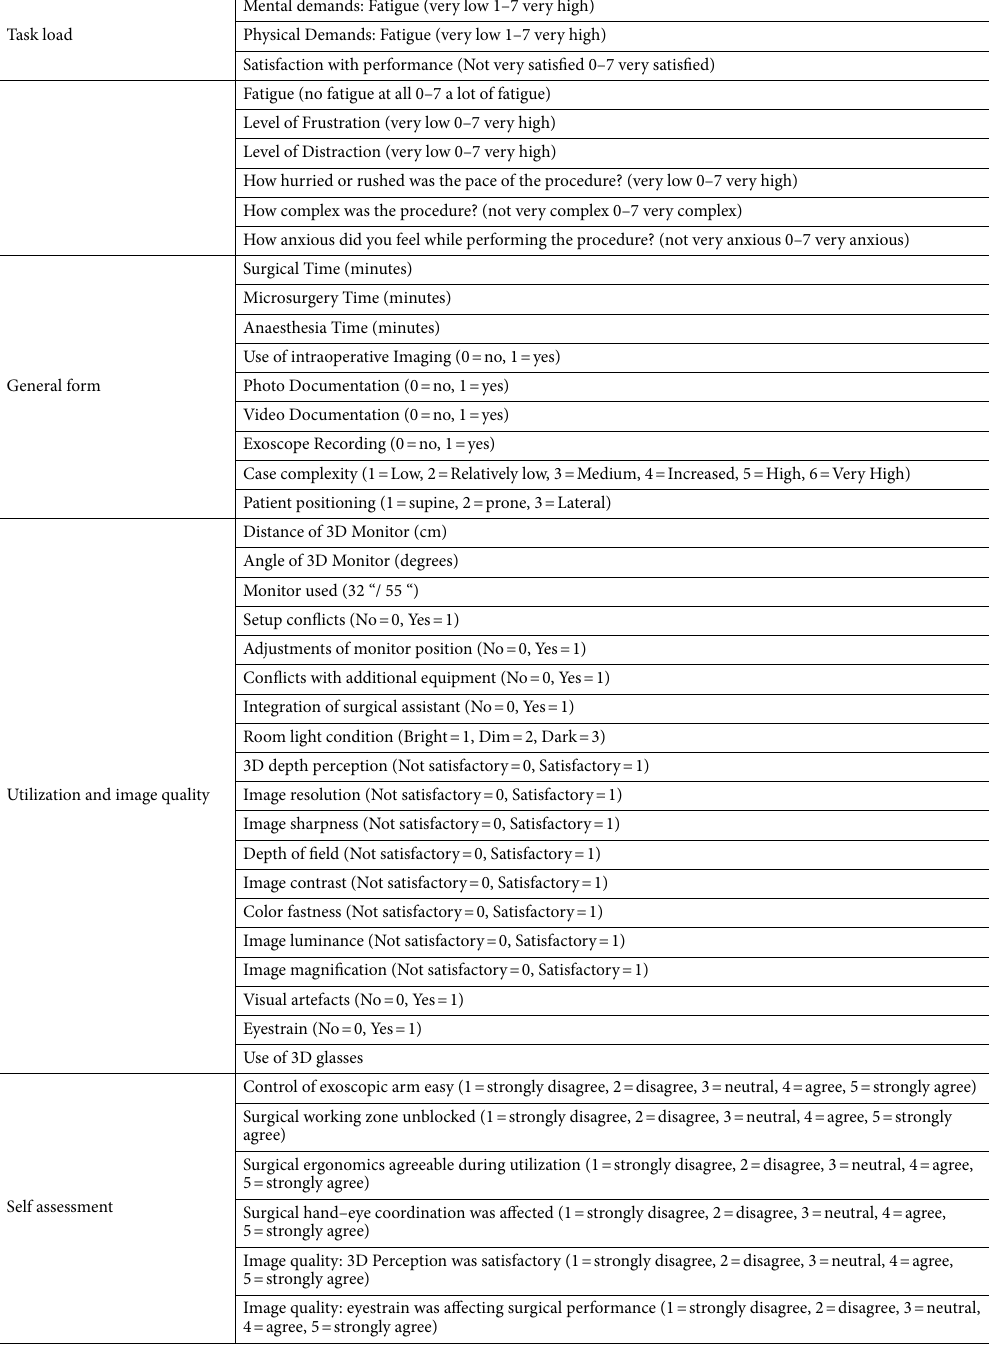
Table 1. Surgeons’ questionnaires classified in 4 categories.